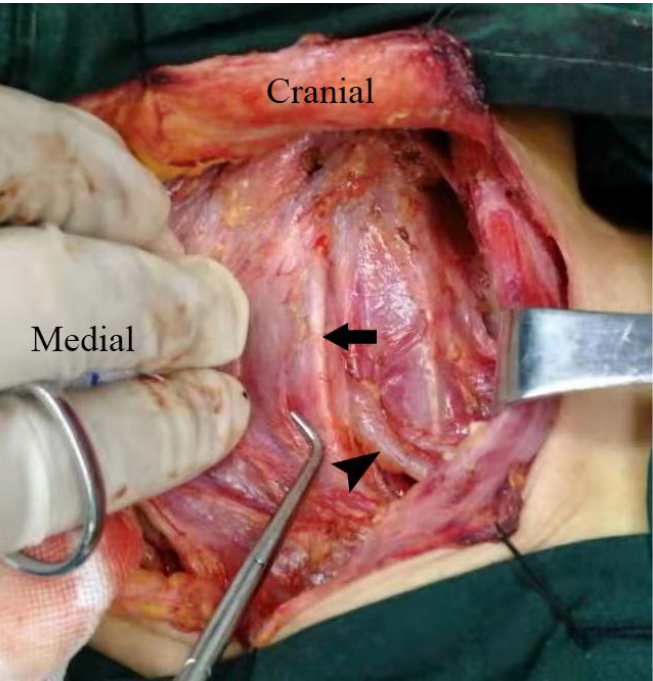
Figure 5. Surgical anatomy of neck illustrating carotid sheath (arrow) and thoracic duct (arrow head) of another patient, showing that thoracic duct passes posterior to the left common carotid artery and injects into the left venous